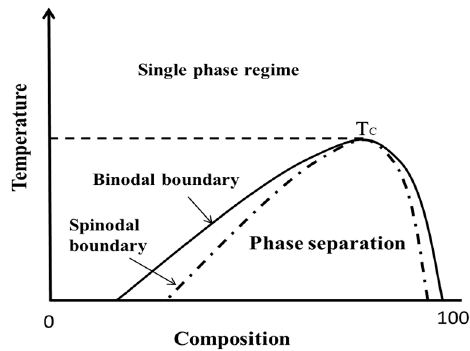
Figure 1. The schematic diagram for the binary system featuring upper critical solution temperature (UCST); the amorphous-amorphous phase separation (AAPS) occurs within both the binodal and spinodal boundary, with a nucleation barrier exists in the gap between binodal and spinodal .